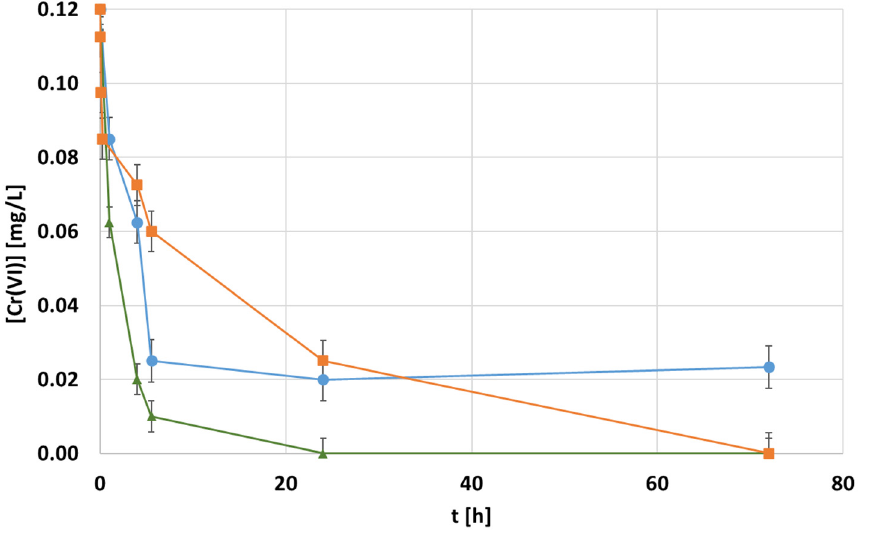
Figure 1. The evolution of the hexavalent chromium concentration [mg · L − 1 ] at 0.1 mg · L − 1 of the initial chromium concentration, pH 3, and 1000 mg CNF · L − 1 of dosage during adsorption with different doses of MTMS in the CNF hydrogels.